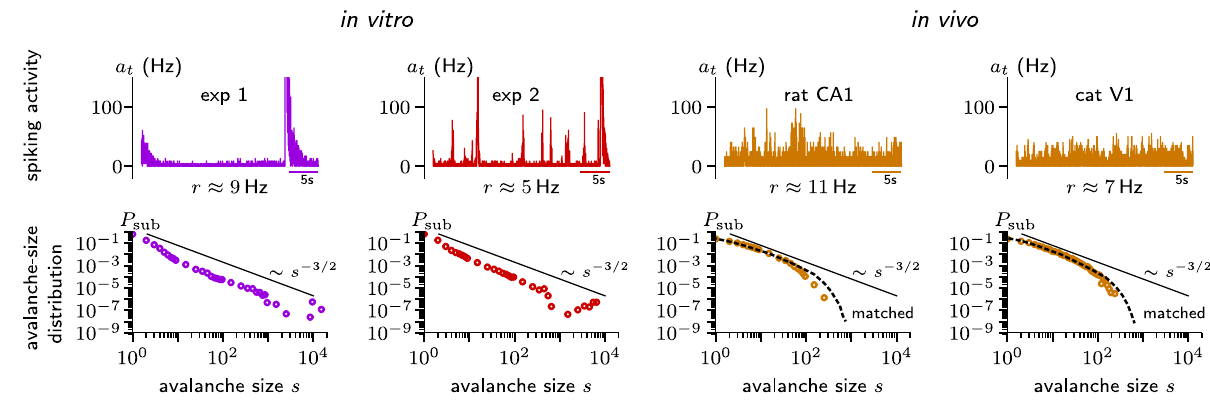
FIG. 1. Examples of dynamic states observed in experiments. In vitro spike recordings are from cultures of dissociated rat cortical neurons [4]. In vivo recordings are from the right dorsal hippocampus in an awake rat during an open field task [21] and from the primary visual cortex in a mildly anesthetized cat [22]. The top row shows population spiking activity (Appendix B-1) from 30 – 60 single or multiunits ( Δ t ¼ 4 ms), with average neural firing rate r ; the bottom row shows subsampled avalanche-size distributions (Appendix B-2). Solid lines indicate the power-law behavior s − 3 = 2 expected for a critical branching process. Dashed lines correspond to distributions obtained from branching networks matched to the experiments of rat CA1 ( τ ¼ 2 s, r (cid:2) ¼ 11 Hz, h ¼ 5 . 5 × 10 − 1 Hz, n ¼ 31 , N ¼ 10 4 , 10 5 s) and cat V1 ( τ ¼ 0 . 2 s, r (cid:2) ¼ 7 Hz, h ¼ 3 . 5 × 10 − 2 Hz, n ¼ 50 , N ¼ 10 4 , Δ t ¼ 1 ms, τ Δ t ¼ 1 ms, τ hp ¼ and a definition of parameters, see Appendix